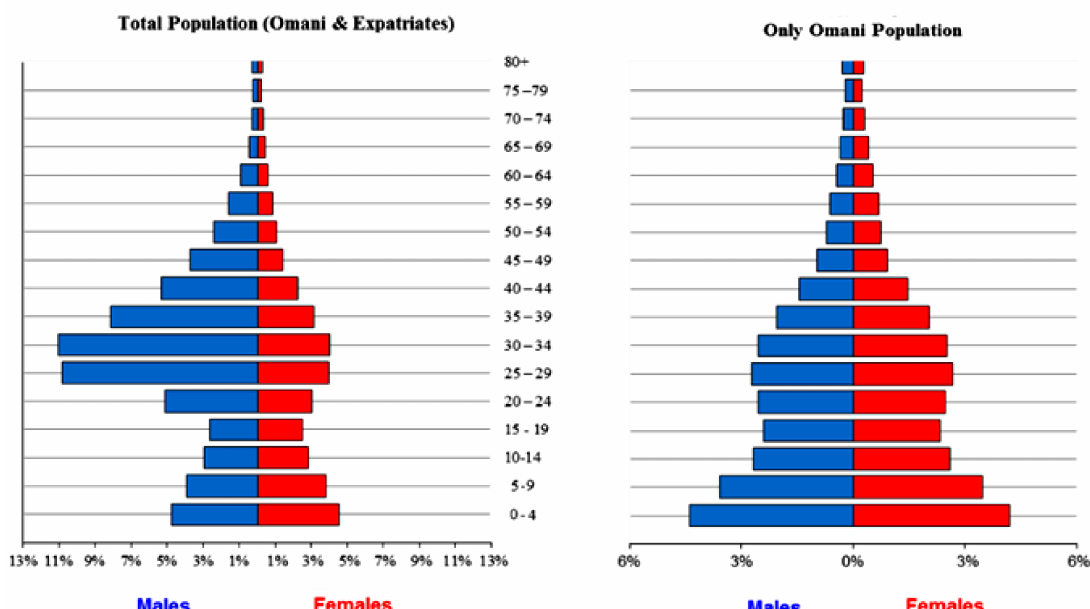
Figure 1. Omani population demographics 2018 [1]. Comparison of the total population (Omani and expatriates) and the Omani population